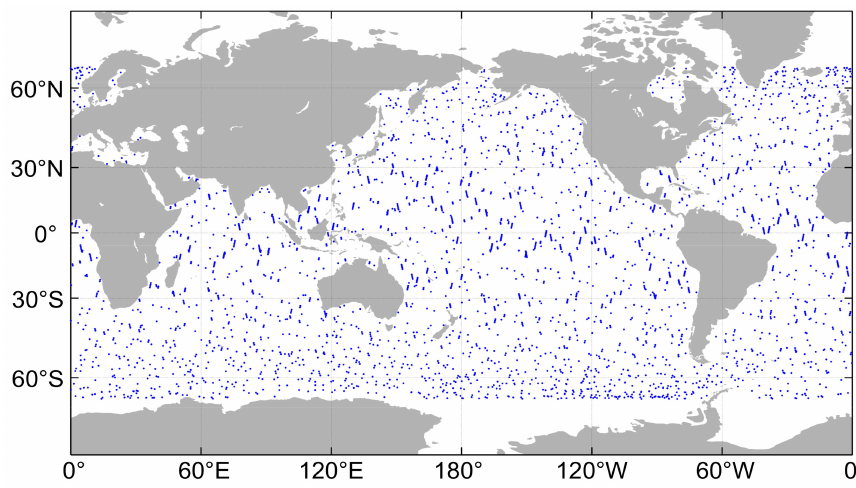
Figure 6. Location of matching data between Jason-3 altimeter and SWIM nadir box SWH data.